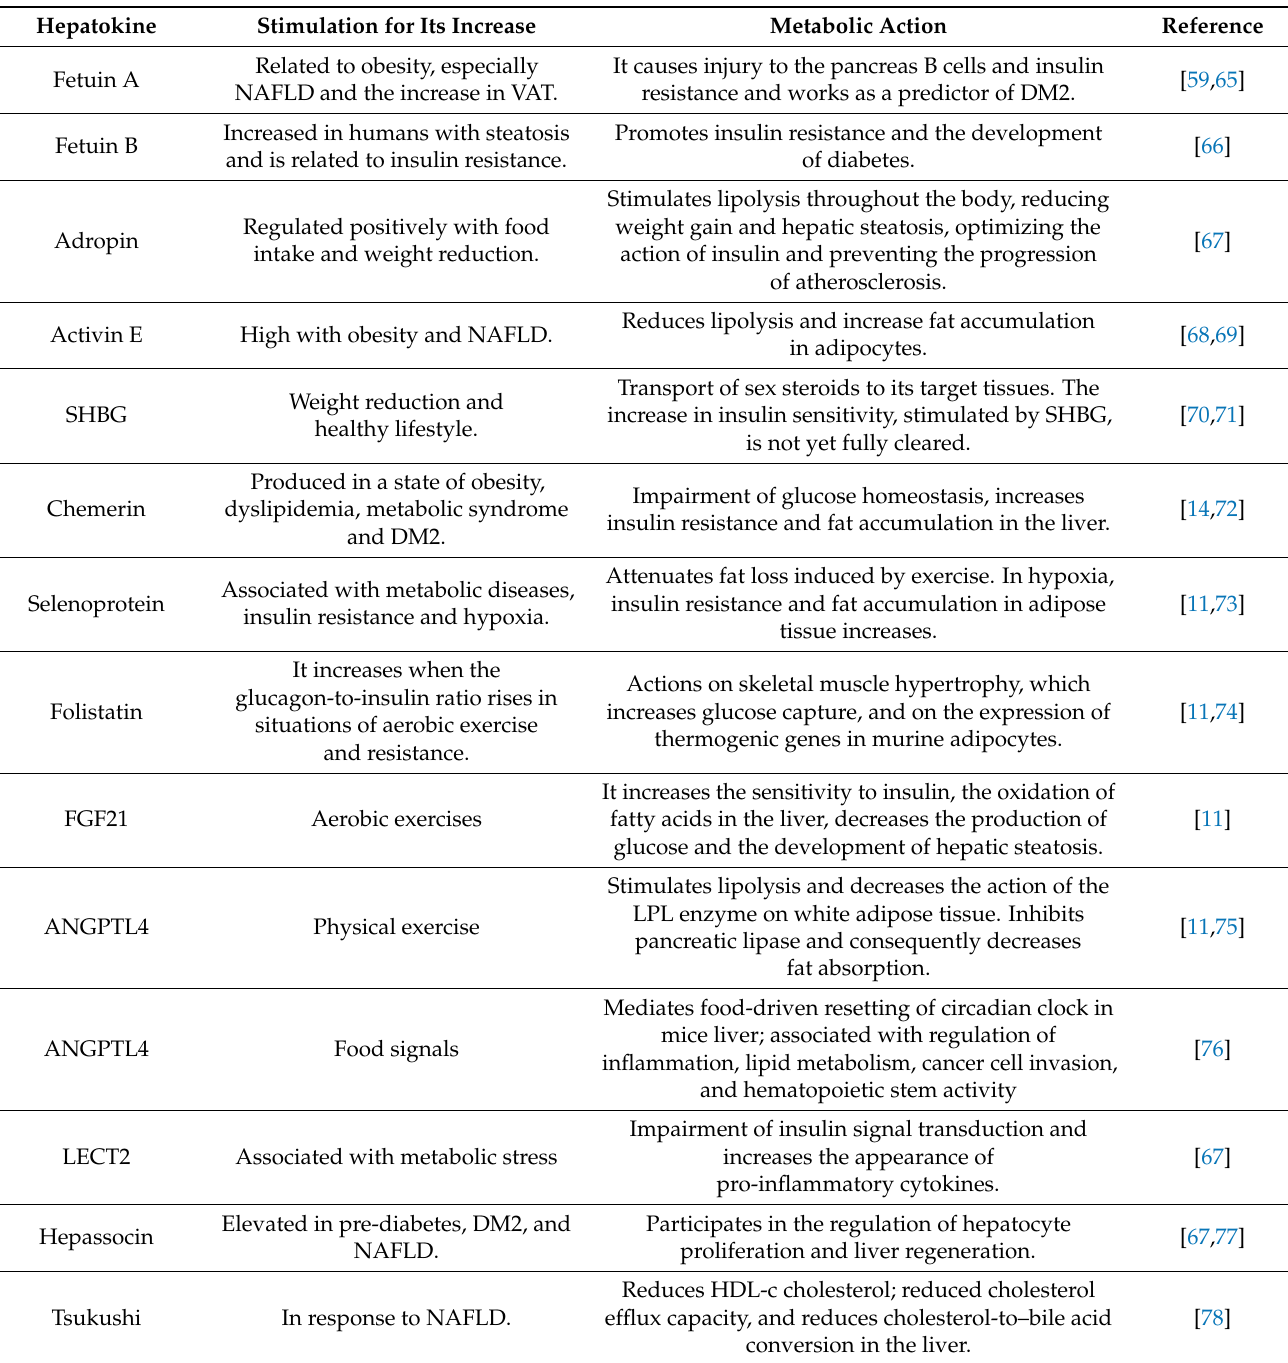
Table 3. Main characteristics of the